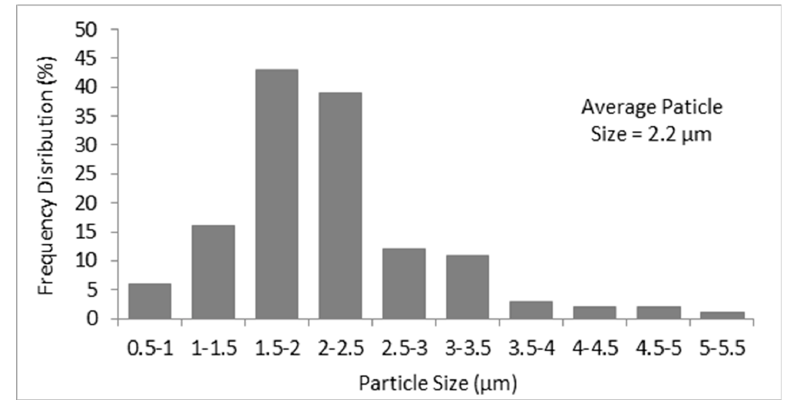
Figure 5. Size distribution bar chart of the particles, resulted from the analysis of the SEM images.